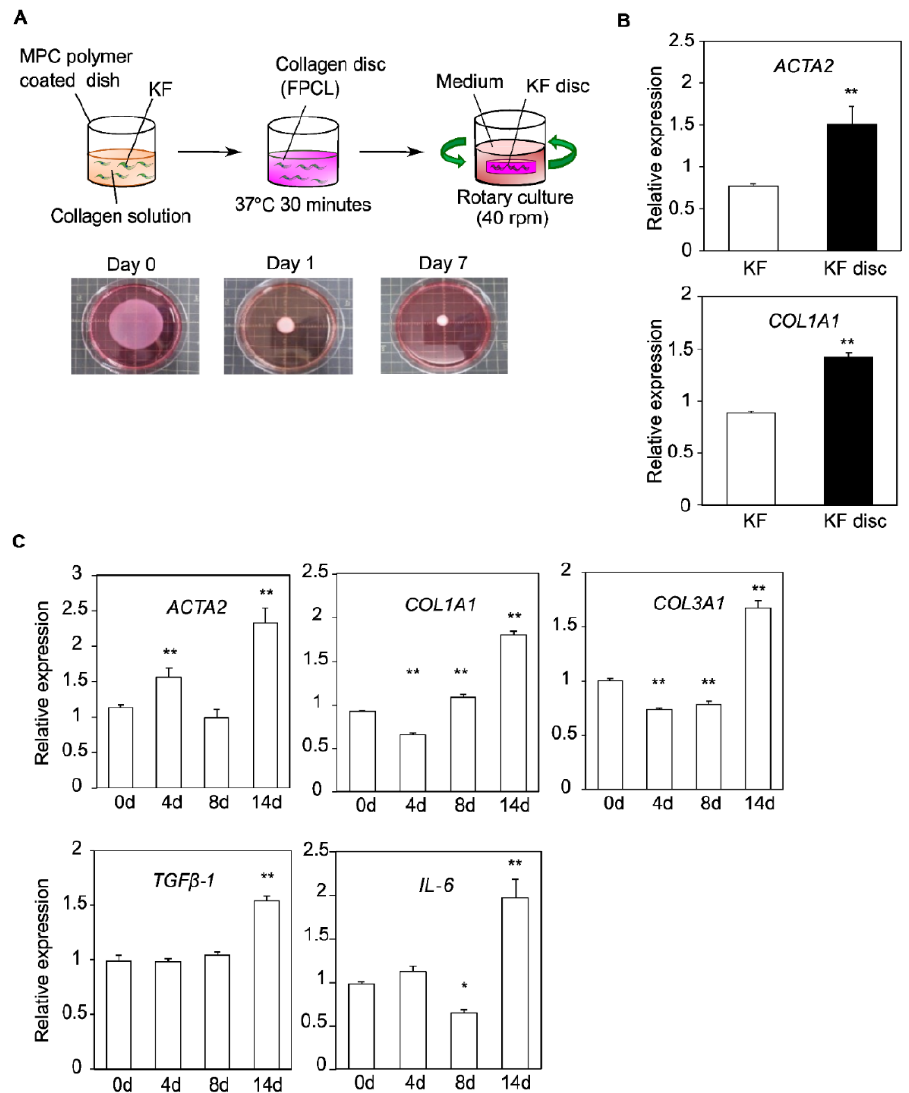
Figure 1. Construction of FPCL contraction model. ( A ) (Above) Schematic representation of establish- ing FPCL contraction model. (Below) Gel contraction is presented by images of KF discs. ( B ) qPCR analysis of ACTA2 and COL1A1 in monolayer cultured KF and KF disc. Results are presented as the mean ± standard deviation of three biological replicates. ** p < 0.01, unpaired Student’s t -test. ( C ) Changes over time in gene expression of scar markers in KF discs. Results are presented as the mean ± standard deviation of three biological replicates. * p < 0.05, ** p < 0.01 compared with day 0 gene expression, one-way analysis of variance followed by Tukey’s multiple method. Abbrevia- tions: FPCL, fibroblast-populated collagen lattice; KF, keloid fibroblasts; qPCR, quantitative real-time polymerase chain reaction; MPC, 2-methacryloyloxyethyl